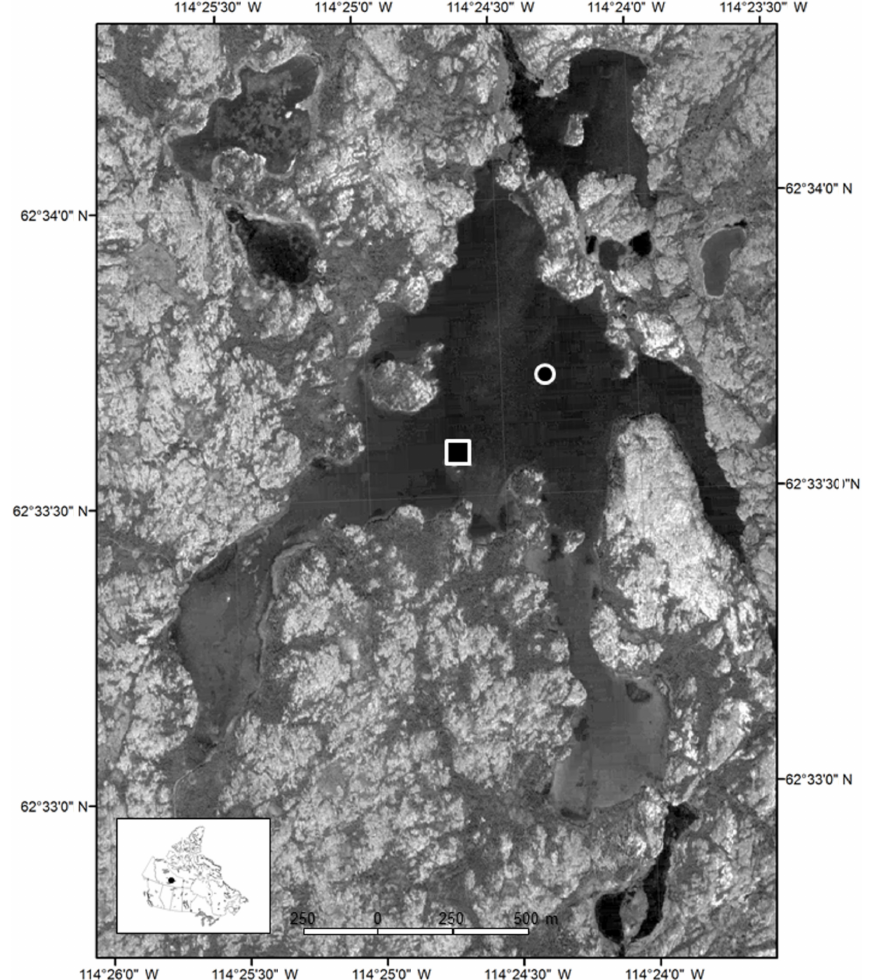
Figure 1. Aerial picture of Landing Lake, with inset map indicating location within Canada. The black square and circle denote locations of climate tower and thermistor string,